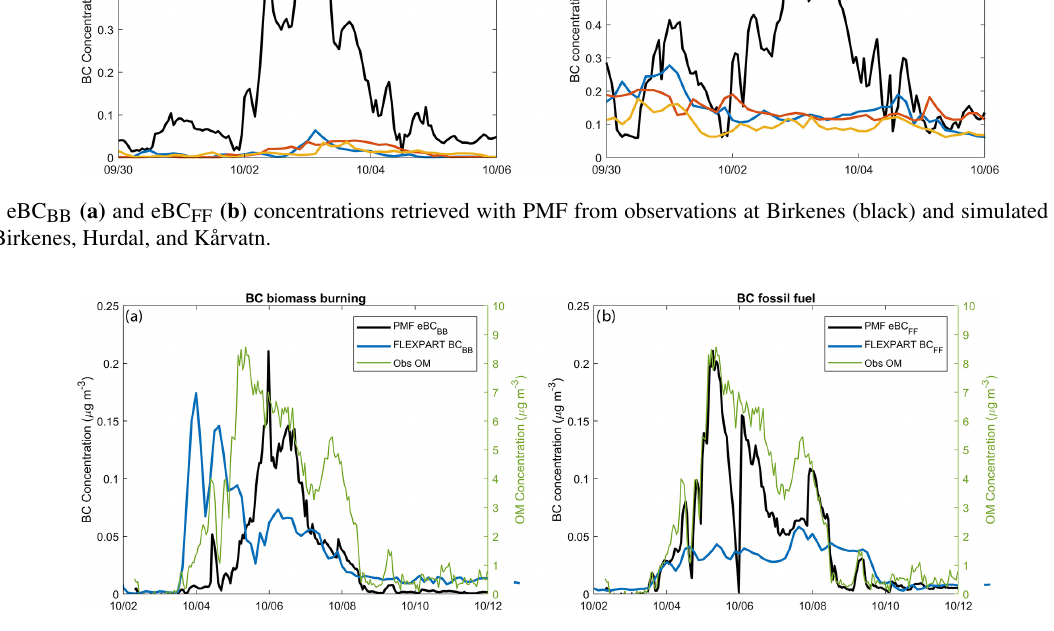
Figure 9. eBC BB (a) and eBC FF (b) concentrations retrieved with PMF from observations (black) and simulated with FLEXPART (blue) and observed OM concentrations (green) at